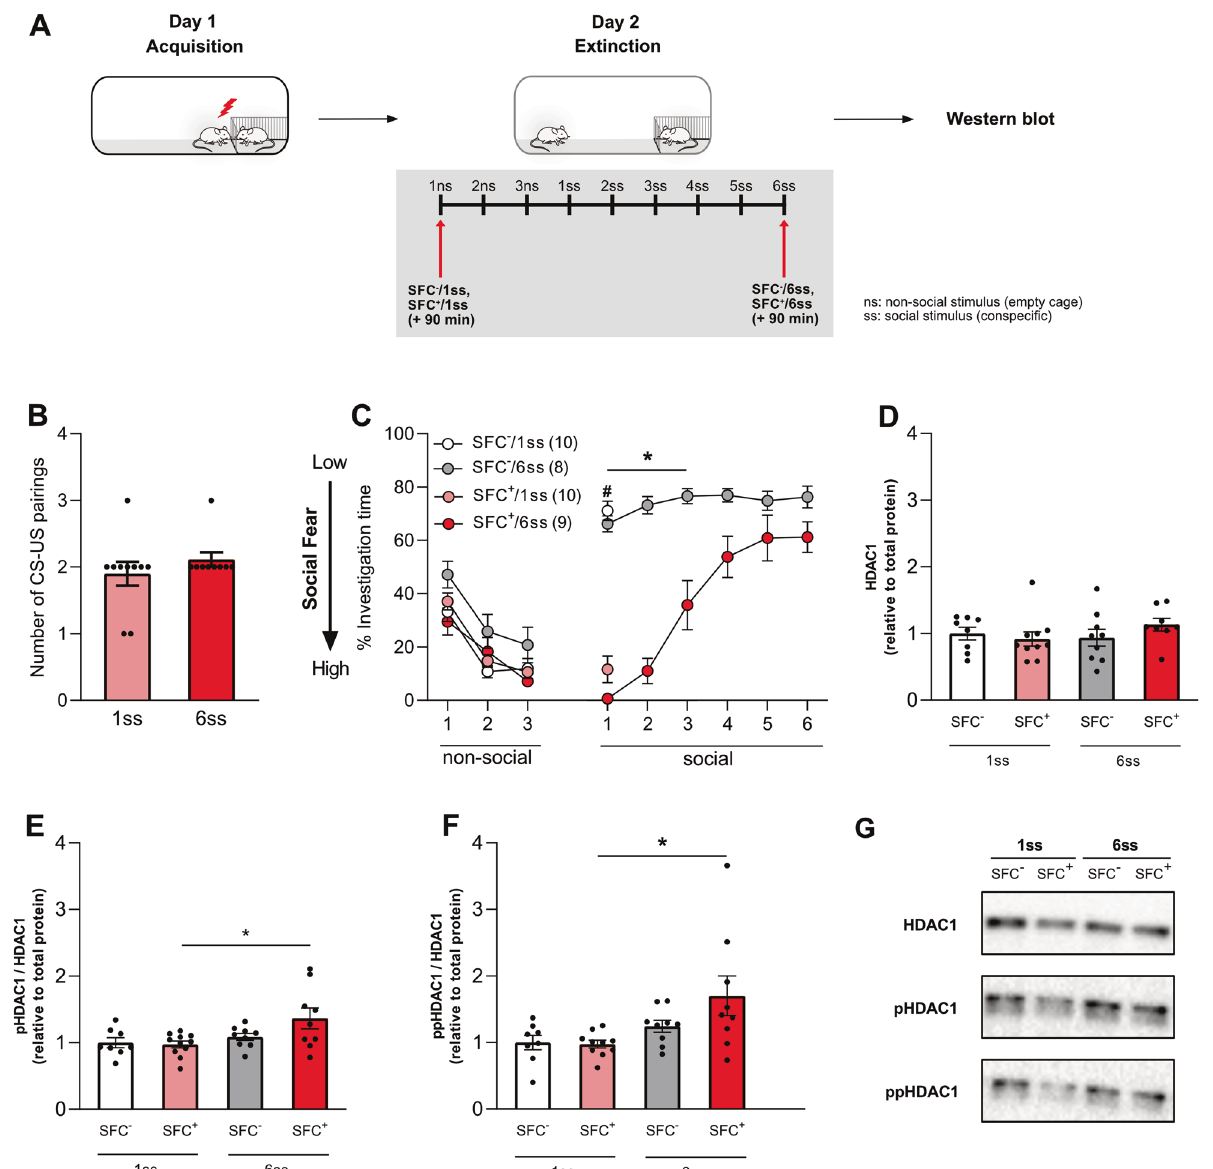
Fig. 1 Phosphorylation on serine residues of septal HDAC1 is upregulated in response to social fear extinction. Schematic representation of the experimental timeline wherein red arrows indicate the time point of sacri fi ce ( A ). Mice were fear conditioned (SFC + ) or left unconditioned (SFC − ) on day 1 of the SFC paradigm. The number of CS-US pairings for groups of SFC + mice exposed to one social stimulus (1ss) and six social stimuli (6ss) during extinction ( B ). Total protein was isolated from the septum 90 min either after abridged social fear extinction (SFC − /1ss and SFC + /1ss n = 10/group) or complete extinction (SFC − /6ss and SFC + /6ss; n = 8 – 9/group; C ). Relative protein levels of HDAC1 ( D ), pHDAC1 (Ser421) ( E ), and ppHDAC (Ser421, Ser423) ( F ) were measured by western blot. Representative western blot images for HDAC1, pHDAC1, and ppHDAC1 ( G ). Data represent mean CS-US pairings ± SEM ( B ), mean investigation time ± SEM ( C ), or fold change + SEM ( D – F ). * P < 0.05 SFC − /6ss vs. SFC + /6ss and # P < 0.05 SFC − /1ss vs. SFC + /1ss ( C ) or between indicated groups ( E , F Western blot analysis did not reveal differences in septal HDAC1 levels between the four groups tested, i.e., between SFC + /1ss, SFC + /6ss, SFC − /1ss, and SFC − /6ss, during extinction of social fear (Fig. 1D). Post-translational phosphorylation of HDAC1 on ser421 (pHDAC1) and double-phosphorylation at ser421 and ser423 (ppHDAC1) are known to increase the deacetylase activity of HDAC1 [28]. Thus, we quanti fi ed pHDAC1 and ppHDAC1 levels within the septum to assess the activation of HDAC1 during social fear extinction. Both pHDAC1 and ppHDAC1 levels were increased in SFC + /6ss compared to SFC + /1ss mice (Fig. 1E; P < 0.05 for pHDAC1 and Fig. 1F; P < 0.05 for ppHDAC1), suggesting an increase in HDAC1 activity during extinction of social fear.